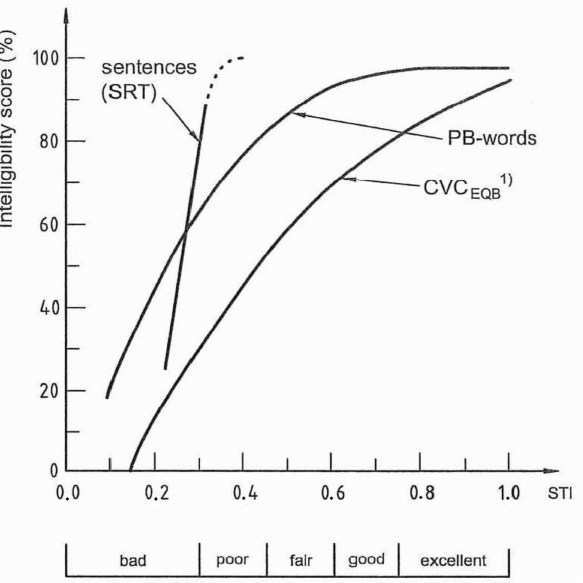
Figure 7. Comparison of intelligibility score and STI using three types of speech intelligibility test